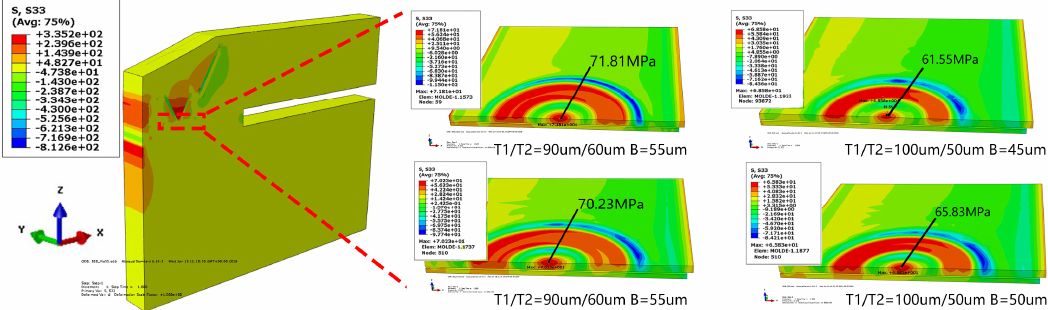
Figure 6. Stress distribution of pad in one TC cycle.